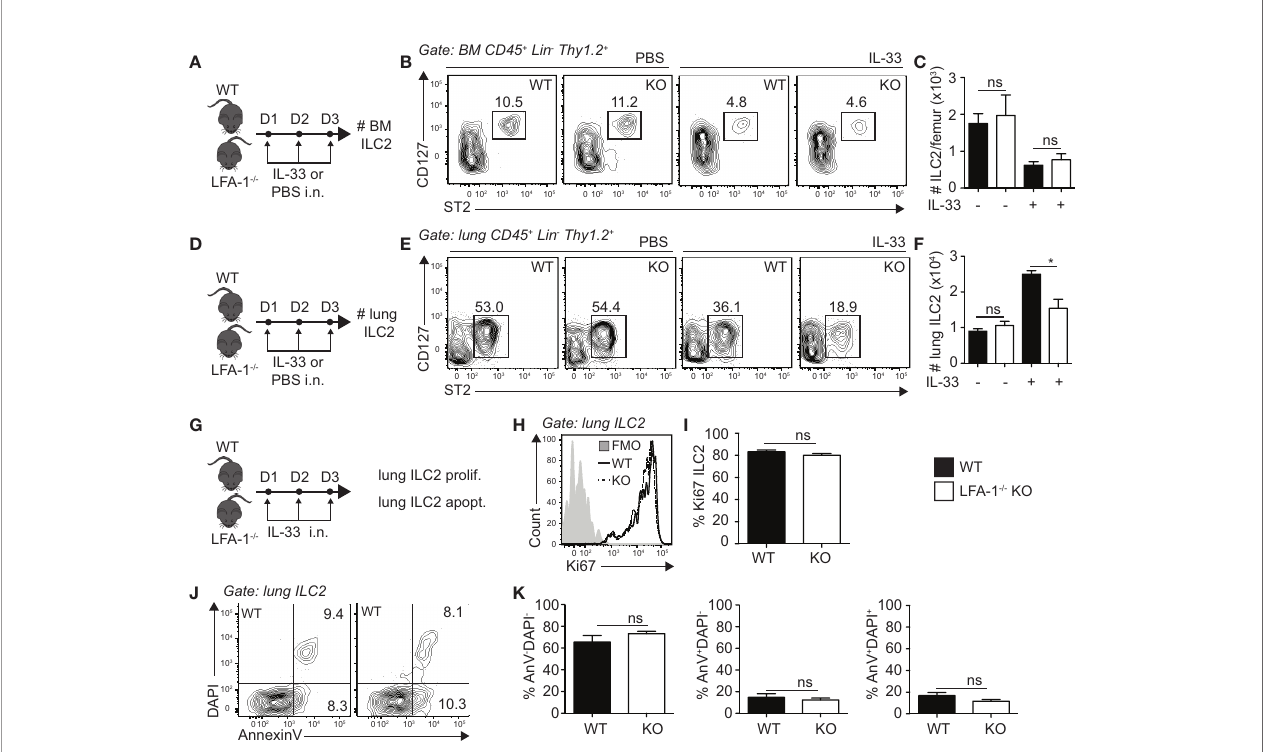
FIGURE 3 | LFA-1 on ILC2s is not required for ILC2 homeostasis in the lungs. (A, D) Cohorts of C57BL/6 (WT) and LFA-1 − / − mice were challenged intranasally on days 1-3 with either PBS or 0.5 µg rmIL-33. On day 4, lungs were recovered as well as the left femur where bone marrow cells were fl ushed in PBS. Both tissues were processed to single cell suspensions, and the presence of CD45 + Lin − Thy1.2 + ST2 + CD127 + ILC2s was analyzed by fl ow cytometry in both the bone marrow (A – C) and the lungs (D, E) . (B) Representative fl ow cytometry plots of PBS-treated (left) and IL-33-treated (right) bone marrow ILC2s in both WT and LFA-1 − / − ILC2s. Corresponding quantitation in (C) is shown presented as the mean number of bone marrow ILC2s ± SEM. (E) Representative fl ow cytometry plots of PBS- treated (left) and IL-33-treated (right) lung ILC2s in both WT and LFA-1 − / − ILC2s. Corresponding quantitation in (F) is shown presented as the mean number of lung ILC2s ± SEM. (G) Cohorts of C57BL/6 (WT) and LFA-1 − / − mice were challenged intranasally on days 1 to 3 with 0.5 µg rmIL-33 and on day 4 lungs were recovered and processed to single cells suspensions. Lung ILC2s were then analyzed for proliferation (%Ki67 + ) (H, I) and apoptosis/survival (% AnnexinV + DAPI + ) (J, K) by fl ow cytometry. (H) Representative fl ow cytometry plots depicting the frequency of Ki67 expression within lung ILC2 populations from WT and LFA-1 − / − mice and (I) corresponding quantitation presented as mean frequency of Ki67 expression within lung ILC2s ± SEM. (J) Representative fl ow cytometry plots depicting the frequencies of AnnexinV - DAPI − (live), AnnexinV + DAPI − (early apoptotic) and AnnexinV + DAPI + (late apoptotic/necrotic) lung ILC2s from WT and LFA-1 − / − mice and (K) corresponding quantitation presented as the mean frequencies of AnnexinV - DAPI − , AnnexinV + DAPI − and AnnexinV + DAPI + within lung ILC2s ± SEM. Data are representative of three individual experiments with n = 5. *p < 0.05, ns, non-signi fi